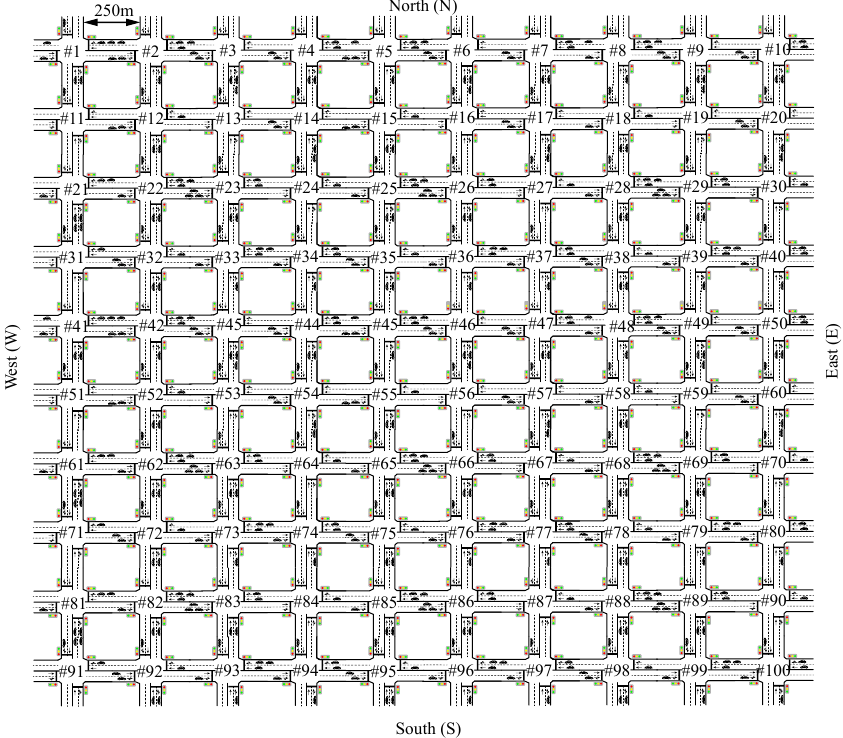
Figure 6. Simulated topology for the testing scenario: Manhattan 10 × 10 network with 250 m between each intersection.